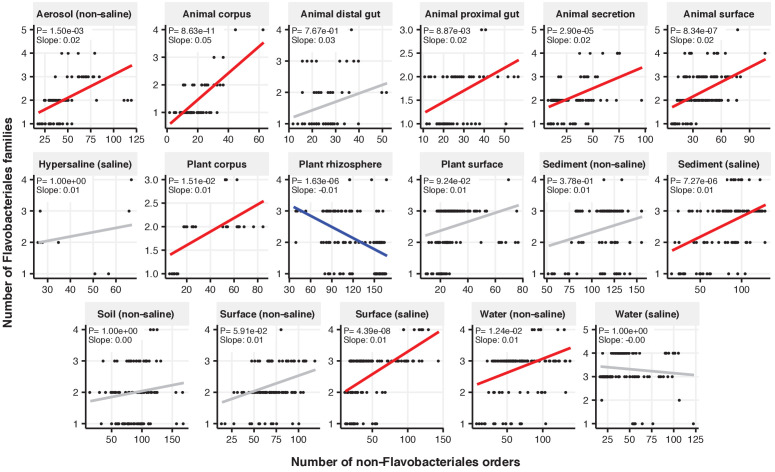
Focal-lineage diversity as a function of community diversity across biomes in Flavobacteriales.Linear models are shown for the number of families per order (y-axis) as a function of community diversity (non-focal orders, x-axis) in each of the 17 environments (EMPO3 biomes). Only environments containing the focal lineage are shown. Significant positive diversity slopes are shown in red, negative in blue (linear models, p<0.05, Bonferroni corrected for 17 tests), and non-significant in grey.